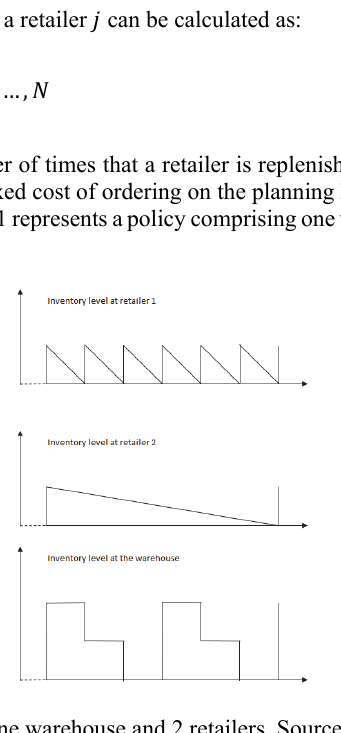
Fig. 1. Inventory policy for one warehouse and 2 retailers. Source: (Abdul-Jalbar et al.,